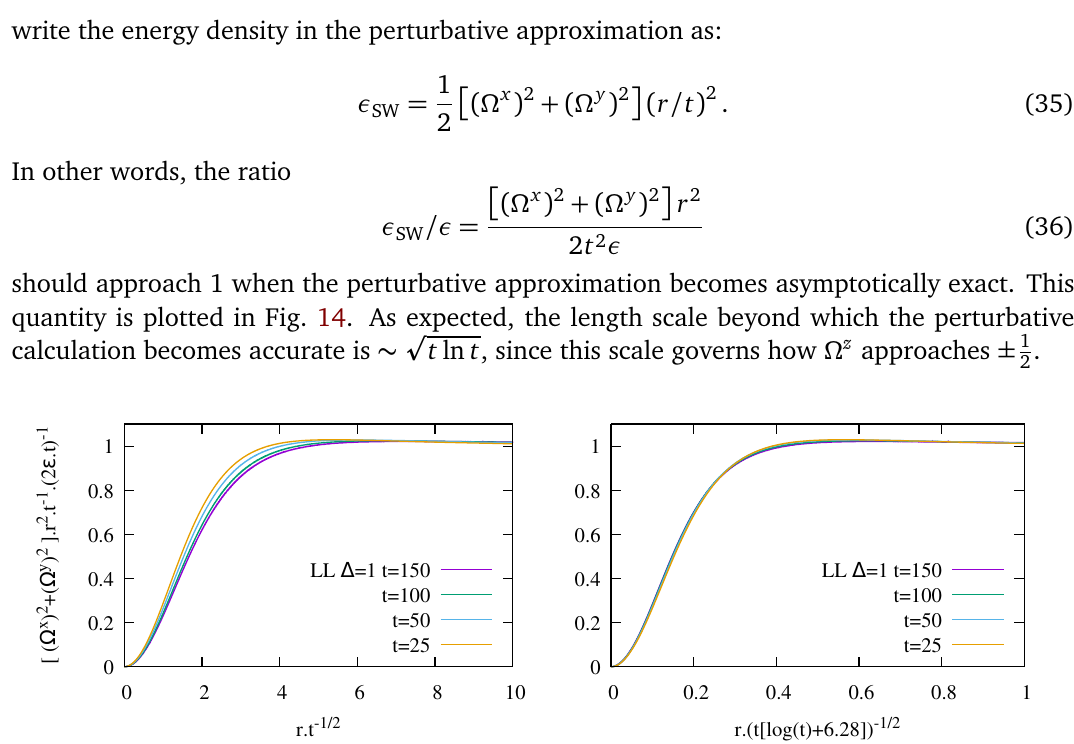
Figure 13: Left panel: LL energy density ε ( r , t ) = 1 tion of r / t for δ = 0 (isotropic model). At sufficient large r / t , the curves associated to different times are practically on top of each other. The growth of ε ( r = 0, t ) with t is compatible with a logarithmic time dependence ( ∼ ln t behavior, see Fig. 16). Right panel: The LL results are compared with XXZ data (black line) at t = 100 (longer times give a similar curves). For the latter there is a maximum group veloc- ity equal to one, which explains why the “signal” is essentially zero for | r / t | > 1. Thanks to the energy conservation, the area of all these curves (LL and XXZ) is equal to 1 . 2